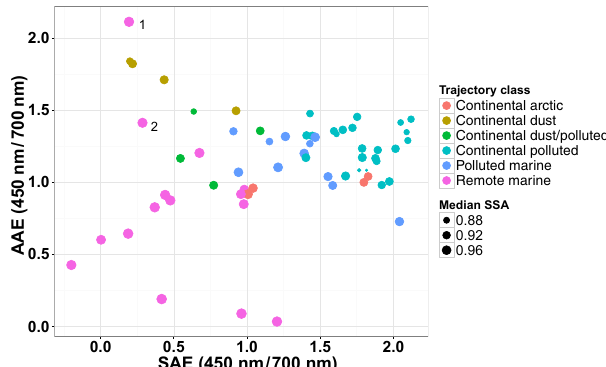
Figure 8. AAE vs. SAE medians plotted for all back trajectory clus- ters from 24 in situ monitoring stations in the NOAA/ESRL Feder- ated Aerosol Monitoring Network. Points are colored by the trajec- tory classification, and sized by the median SSA value of measure- ments from that trajectory cluster, such that smaller points indicate low SSA values and larger points indicate high SSA values. The points labeled 1 and 2 are back trajectories from CPR that are out- liers discussed in the text in Sect.